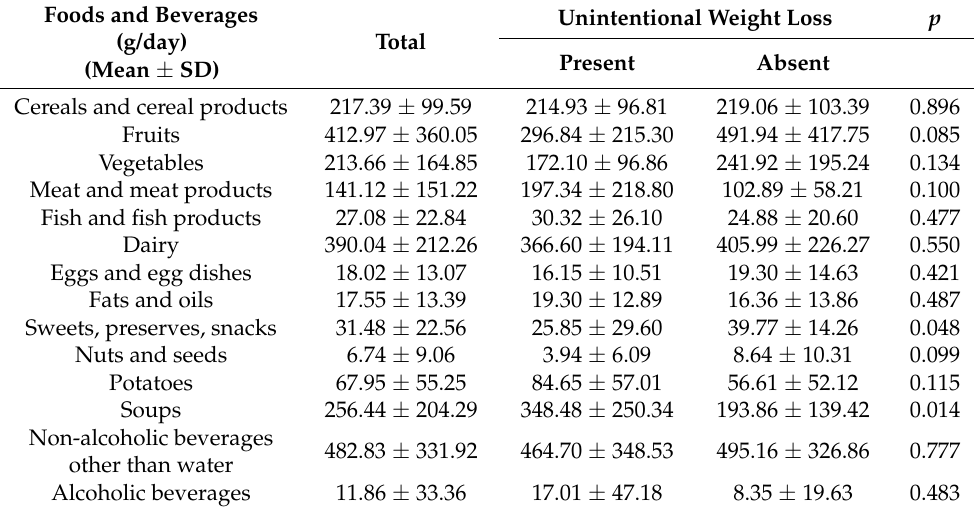
Table 3. The average daily consumption of various foods and beverages in patients with and without weight